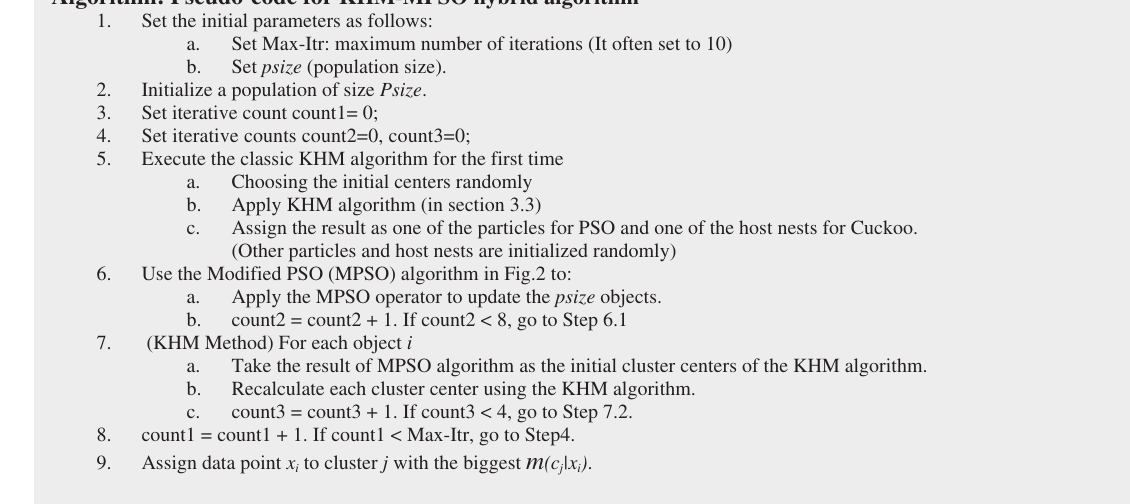
Algorithm: Pseudo-code for KHM-MPSO hybrid algorithm 1.